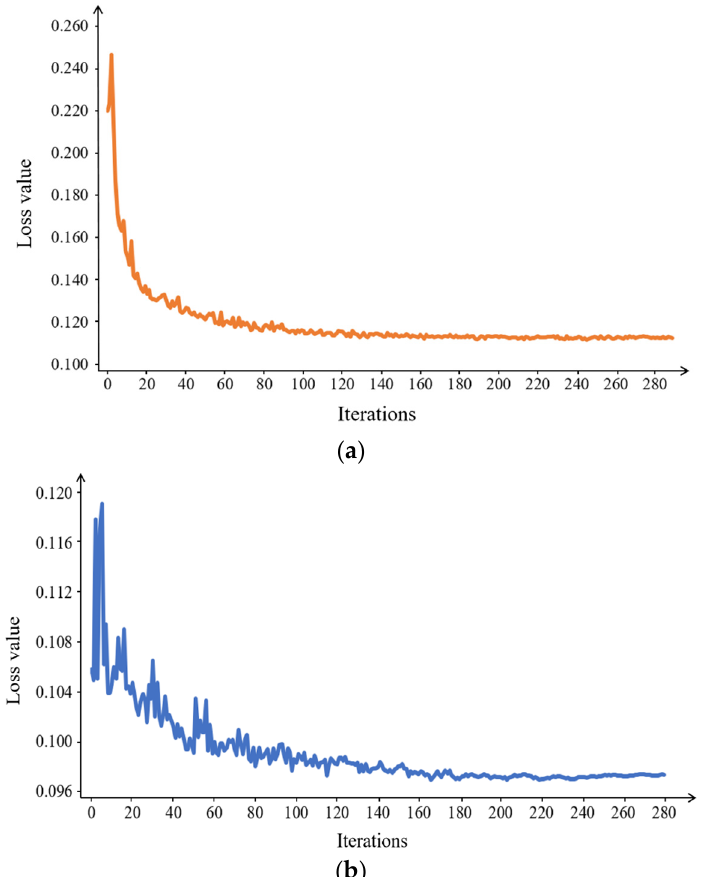
Figure 10. Comparison of loss before and after model distillation: ( a ) Student Net before knowledge distillation; ( b ) Student Net after knowledge distillation.